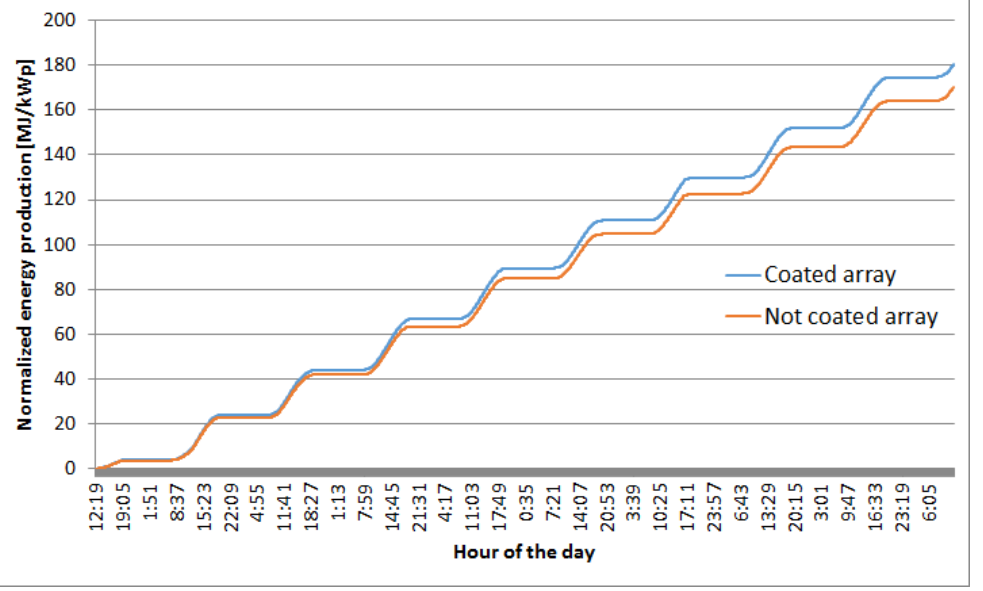
Figure 6. Normalized energy production during the first monitoring